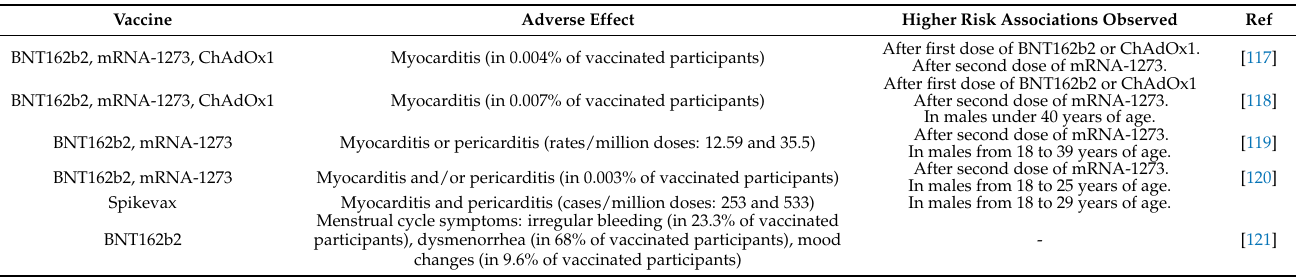
Table 2. Adverse effects and the associated risk factors observed after mRNA vaccination in different